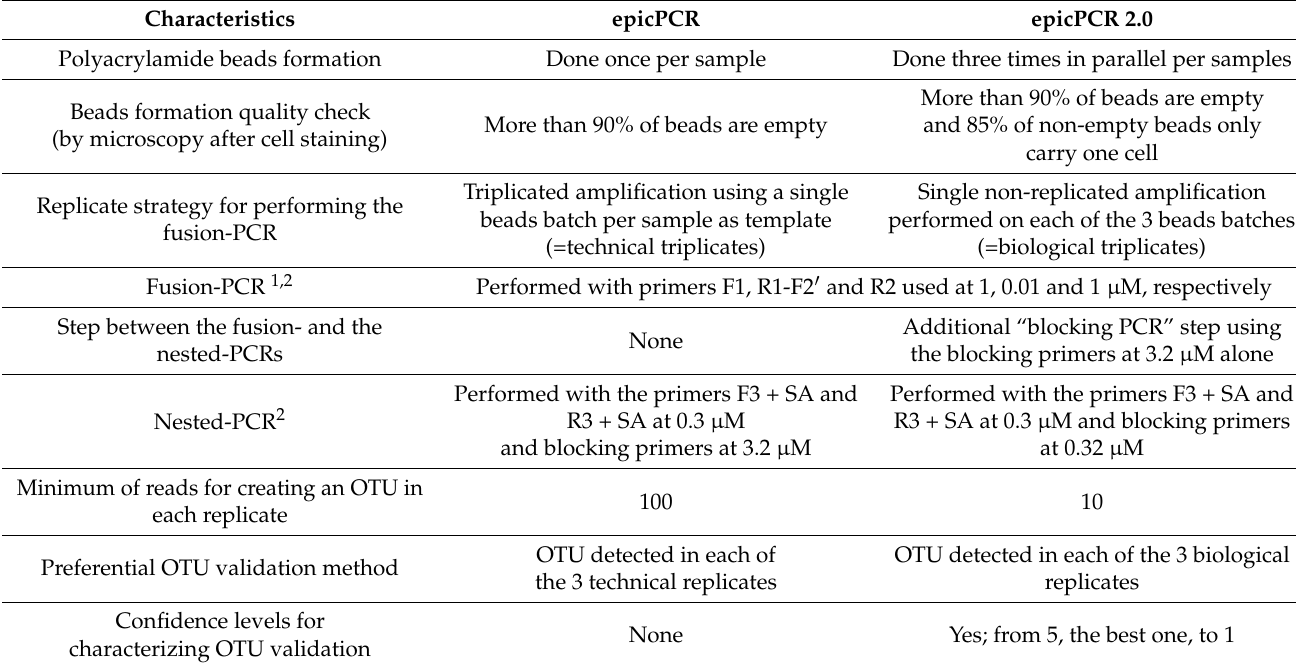
Table 1. Comparison of the main characteristics of the initial epicPCR and the improved epicPCR 2.0 approaches. Characteristics